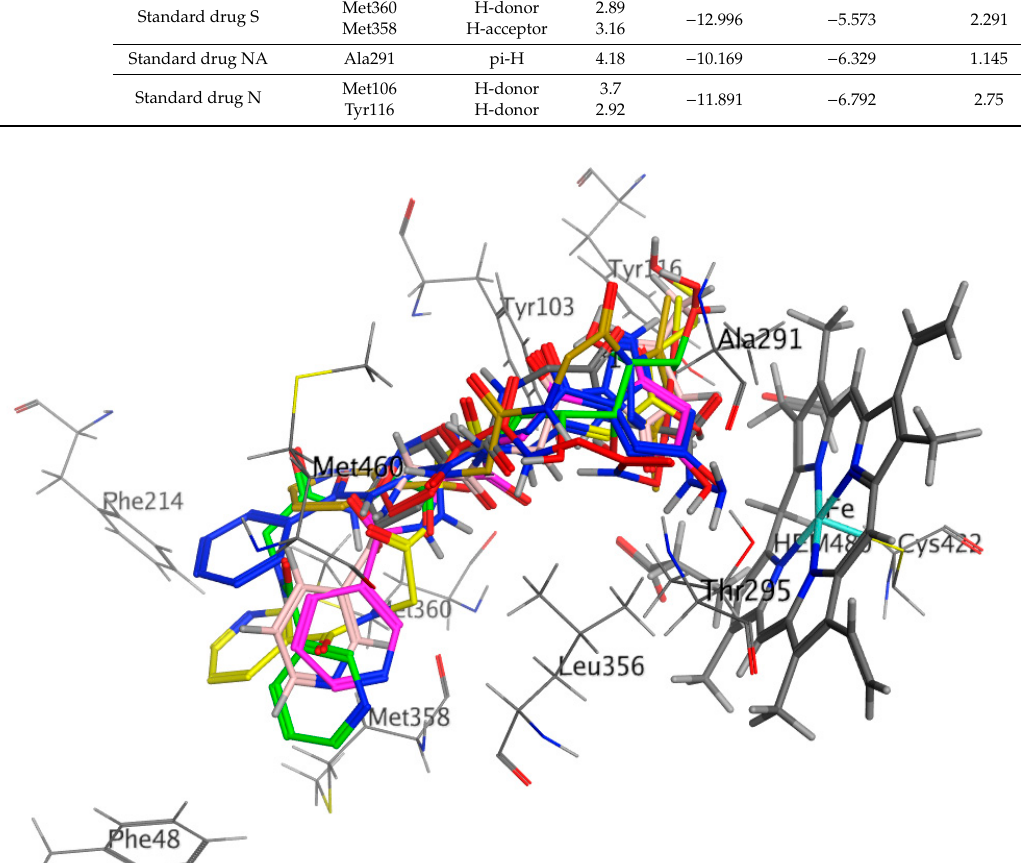
Figure 1. Compounds 4 to 11 superimposed by their non-covalent-docking poses in the active site of PBP3 pocket.